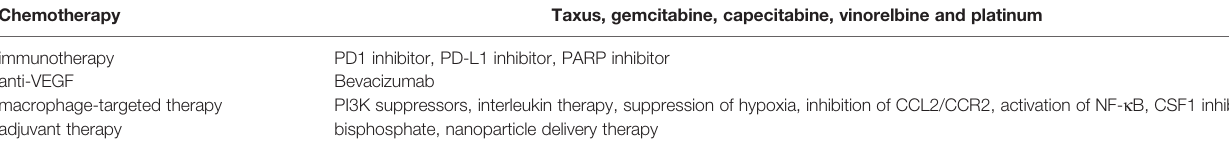
TABLE 2 | Treatment of triple negative breast